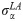
Genes with similar expression patterns and controlled by the same up-stream regulators show an enhanced tendency to co-localize spatially in the 3D chromosome structure.(A) Heat map shows the numbers of 1-Mb bins containing a given number of genes and TGF-β responding genes. The orange line highlights the bins in which all genes responded to TGF-β treatment. (B) Linear and radial distribution functions of TGF-β-responding genes within two representative HMM classes. We calculated the distribution of genes by sampling three types of gene groups: all available genes (All genes, σαLA and σαAR), genes within an indicated HMM group (HMM genes, σαL and σααR), and genes that showed differential expression during TGF-β treatment (DE genes, σαLD and σαDR). For spatial distance, with the shell width Δr approx 60 nm. (C) Pseudo-spatial arrangement of genes belonging to two representative HMM classes, respectively. Each circle indicates a 1-Mb bin. The gray level in a circle scales to the number of genes in the bin that belongs to the indicated HMM class. The two-dimensional spatial arrangement of bins within one chromosome was calculated by a fast-greedy algorithm based on the contact frequencies between each pair of bins from Hi-C data. The line width between two circles is proportional to the contact frequencies between the two corresponding bins. Genes within each red box are within ~ 300 nm in space. (D) Relative gene densities of all HMM classes within the first shell of the radial distributions normalized by the average density of all genes around the targeted genes in the first shell (i.e., σααR(0)/σαAR(0) and σαDR(0)/σαAR(0)).